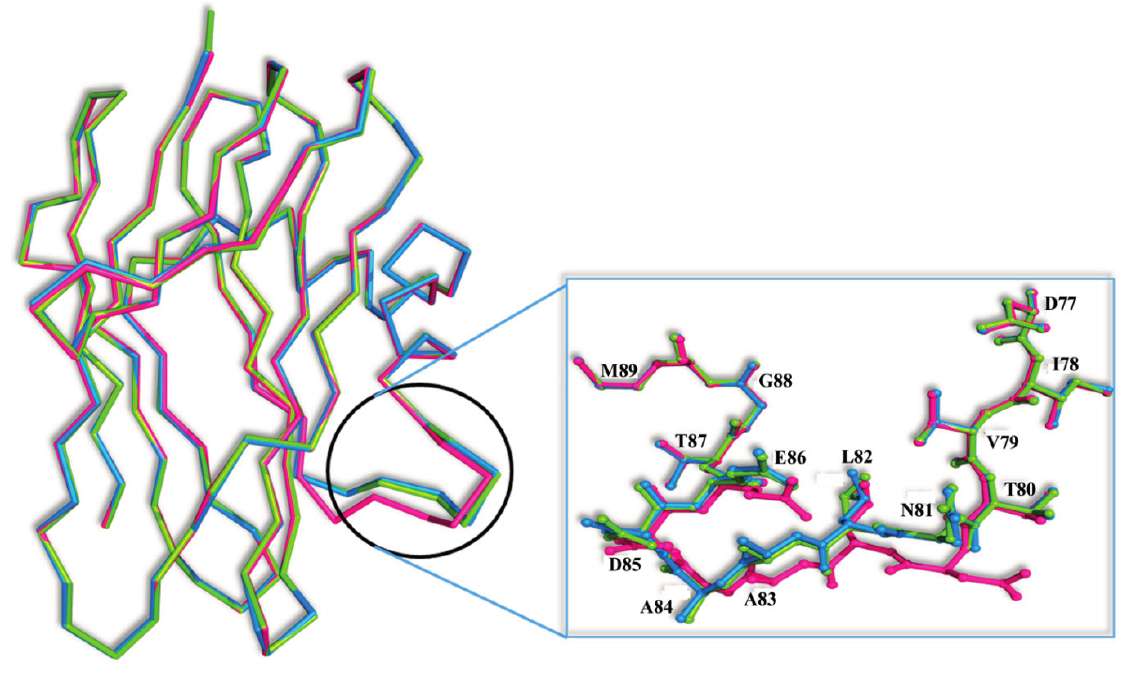
Figure 5. S uperposition of the C α traces of the SRL (magenta), SSR1 (blue) and SSR2 (green) monomers. Inset: residues 81–86 are shown as ball-and-stick